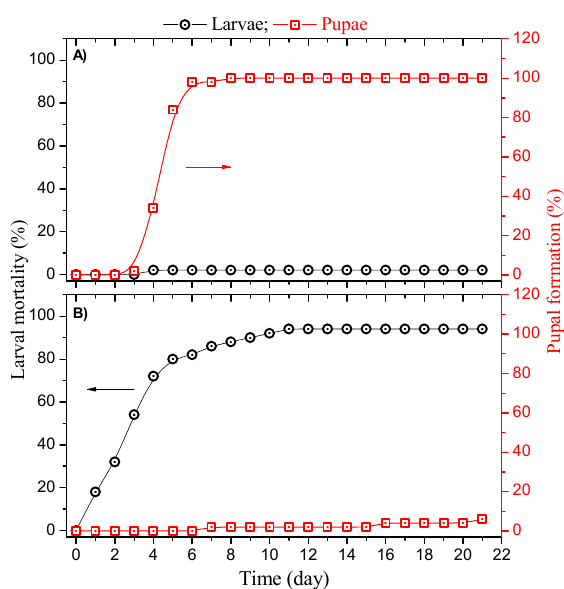
Figure 2. Pupal formation and larval mortality rate in the ( A ) control group submitted to sucrose formulation and ( B ) experimental group with curcumin/sucrose formulation as a function of the number of days in the field. Arrows indicate the y -axis for mortality (black) and pupal formation (red). The L 3 larvae in the control group reached the fourth instar (L 4 ) between the third and fourth days in the field (data not shown). On the fifth day, 97% of the larvae evolved to pupal condition (Figure 2A). All larvae achieved the pupal stage on the seventh day. According to the literature, the larval life cycle of Ae. aegypti is about 7 days in a microbiota favorable for its development [33,34]. The pupation time occurred 13 days after the